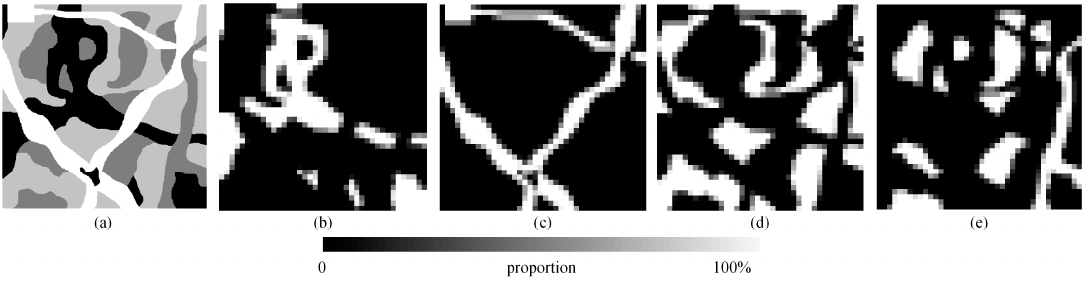
Figure 6. Proportional images of four classes with a scale of 12. ( a ) Reference image, ( b ) class 1, ( c ) class 2, ( d ) class 3, ( e ) class 4.